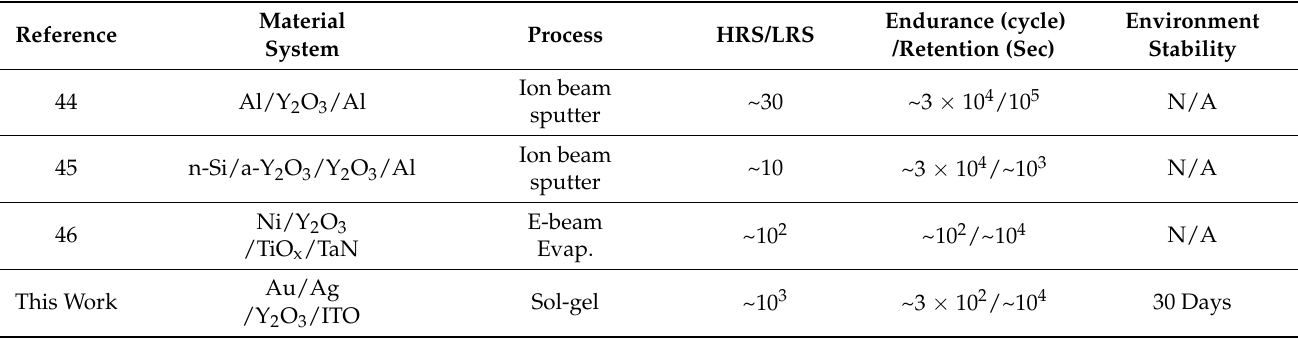
Figure 7. The nonvolatile memory characteristics of 30-day stored Y 2 O 3 RRAM devices: ( a ) Representative endurance characteristics of Y 2 O 3 RRAM devices with Ag and Au/Ag electrodes and ( b ) representative retention characteristics of Y 2 O 3 RRAM devices with Ag and Au/Ag electrodes. Table 1. Comparison of Y 2 O 3 RRAM device performance parameters.